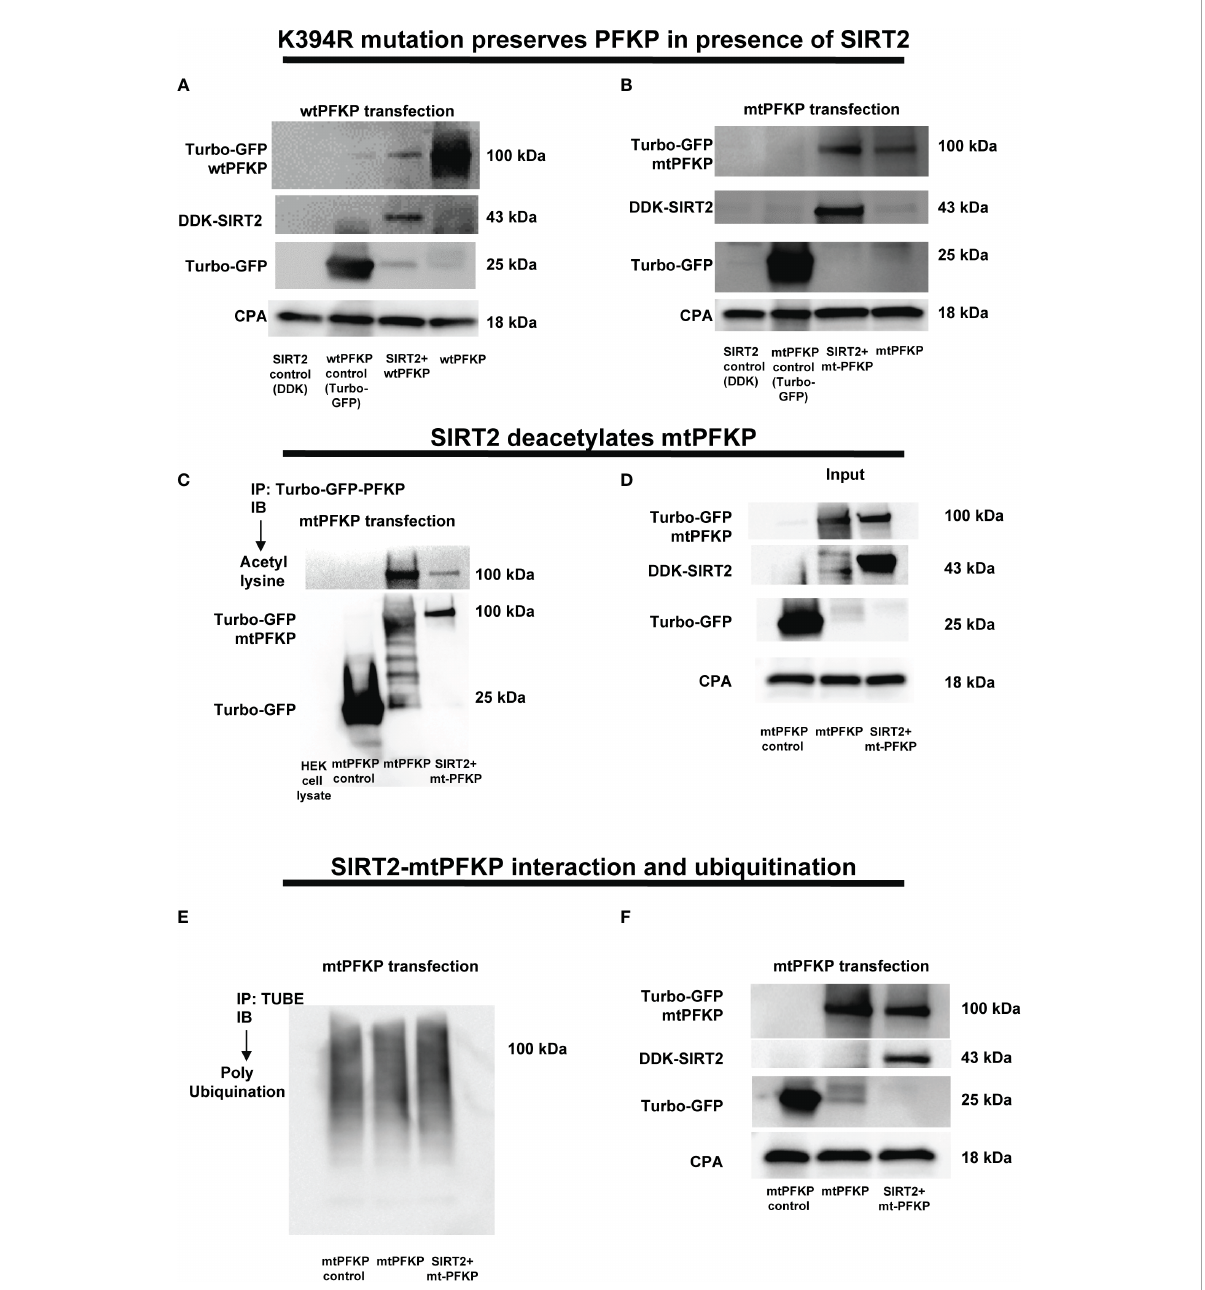
FIGURE 6 Effect of K394R mutation on PFKP. (A, B) HEK293T cells transfected with wtPFKP/mtPFKP in the presence or absence of SIRT2. Western blot analysis of Turbo-GFP-wtPFKP, DDK-SIRT2, turbo-GFP (control for wtPFKP plasmid transfected) and CPA. (C) mtPFKP transfection and IP using turbo-GFP-trap in HEK293T cells, in presence or absence of SIRT2 followed by IB analysis of acetyl lysine, turbo-GFP-mtPFKP and turbo-GFP (control for wtPFKP plasmid transfected). Pulldown with HEK293T cell lysate without transfection was used as a negative control. (D) Western blot analysis of turbo-GFP mtPFKP, DDK-SIRT2, turbo-GFP and CPA in whole cell lysate, used as an input for the turbo-GFP IP. (E) mtPFKP transfection and IP using magnetic-TUBEs in HEK293T cells, in presence or absence of SIRT2 followed by IB analysis of ubiquitination. (F) Western blot analysis of turbo-GFP mtPFKP, DDK-SIRT2, turbo-GFP and CPA in whole cell lysate used as input for the TUBE